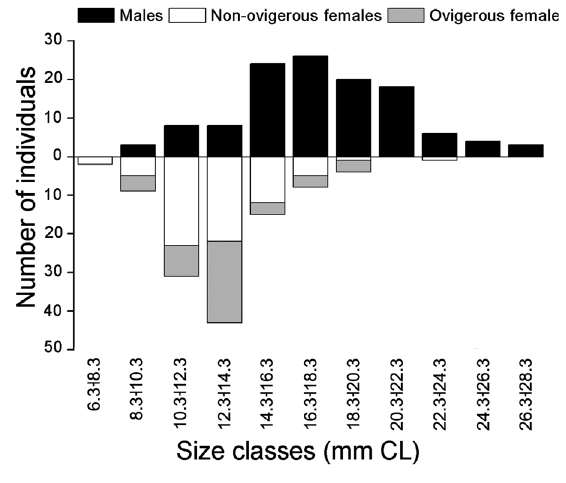
Figure 3. Atya scabra (Leach, 1816). Size-frequency distribution of carapace length (mm) of the male and female shrimp sampled in São Francisco River, Sergipe,